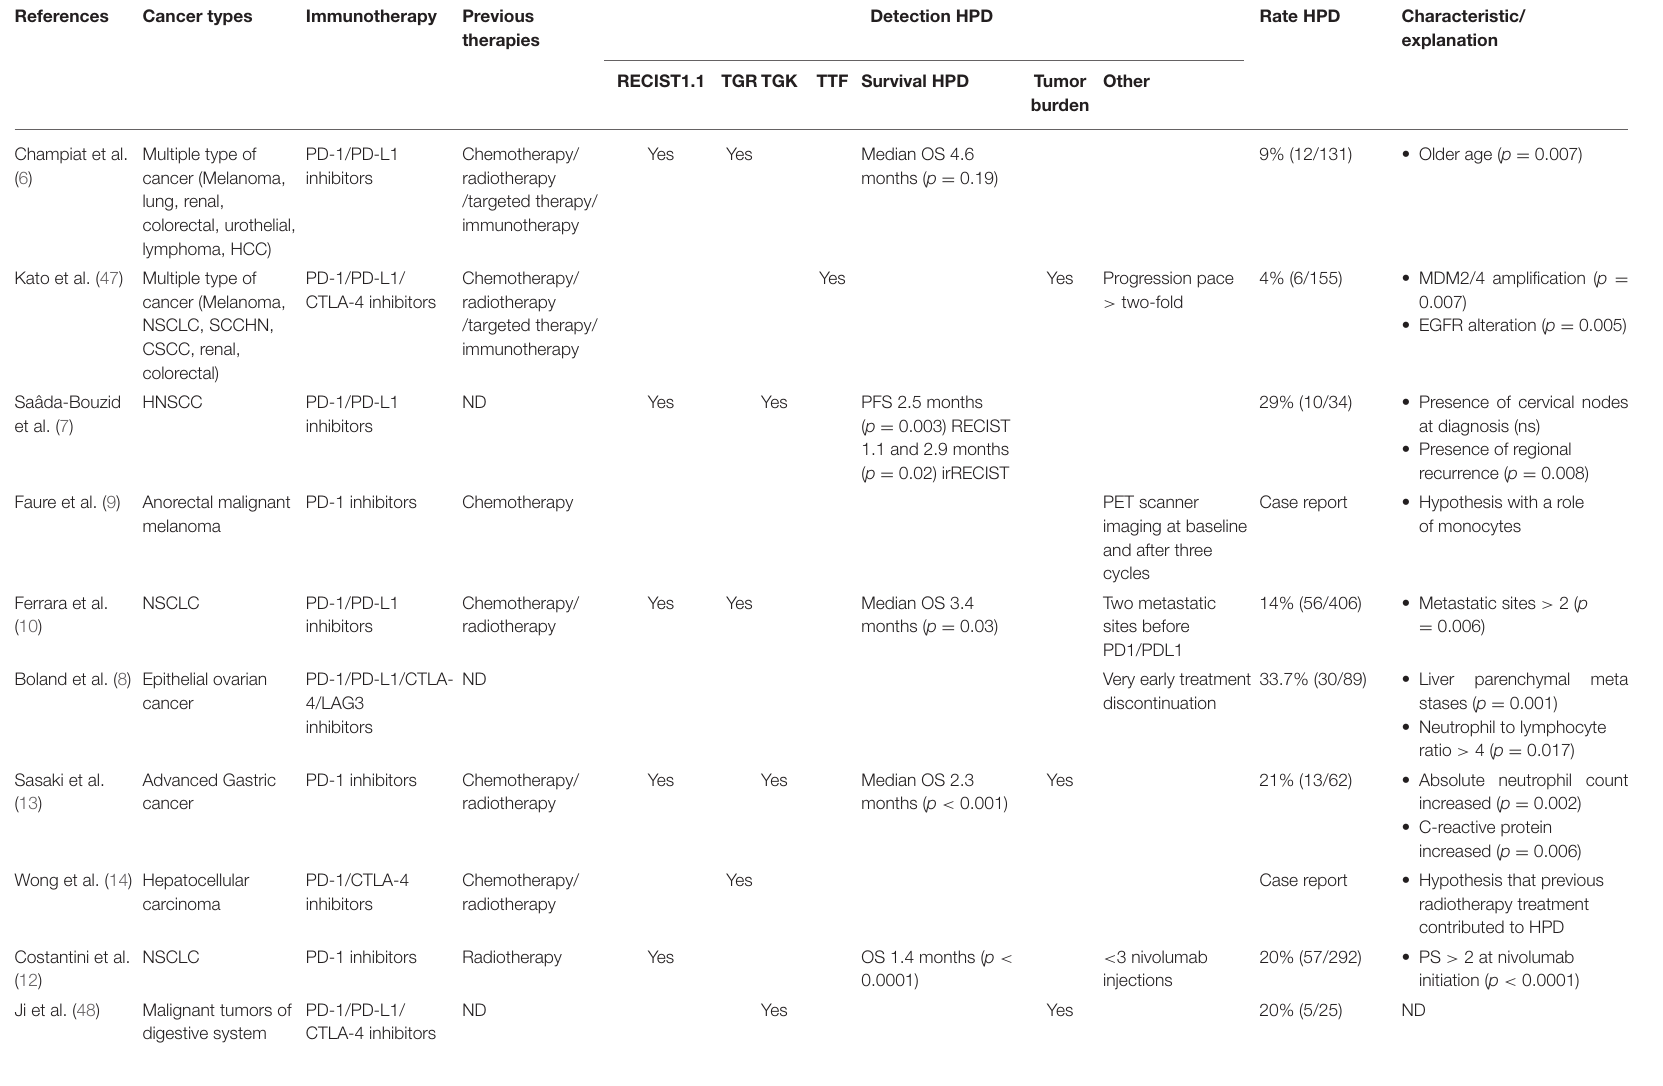
TABLE 1 | Studies reporting hyperprogressive disease